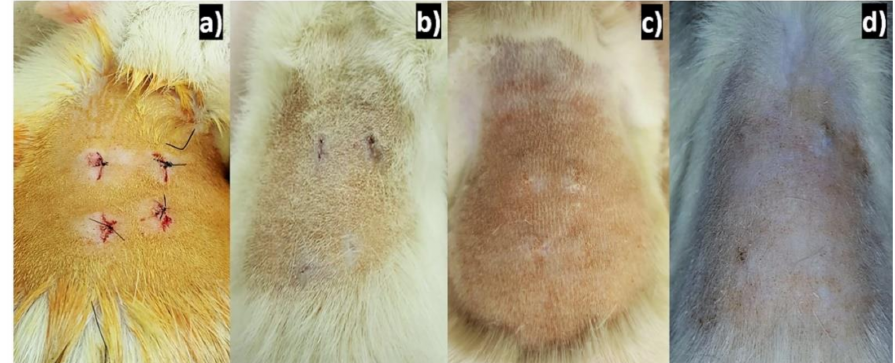
Figure 4. Surgical points in the dorsal area of Wistar rats after implantation: ( a ) just implanted the PCL/Ag, ( b ) two weeks after implantation, ( c ) four weeks after, and ( d ) 6 weeks after implantation.